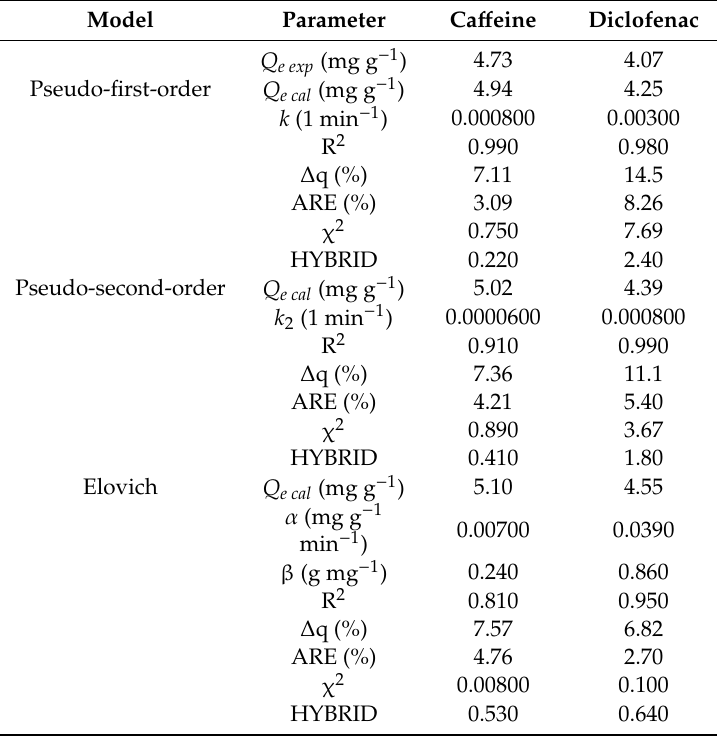
Figure 4. Kinetics adsorption of CFN onto FB850-3 by fitting the pseudo-first-order, pseudo-second-order and Elovich model ( a ), adsorption kinetics of DCF onto FB850-3 by fitting the pseudo-first-order, pseudo-second-order and Elovich model ( b ). Table 2. Parameters of different kinetic models and statistical indices for the adsorption of caffeine and diclofenac onto FB850-3 at 20 °C.